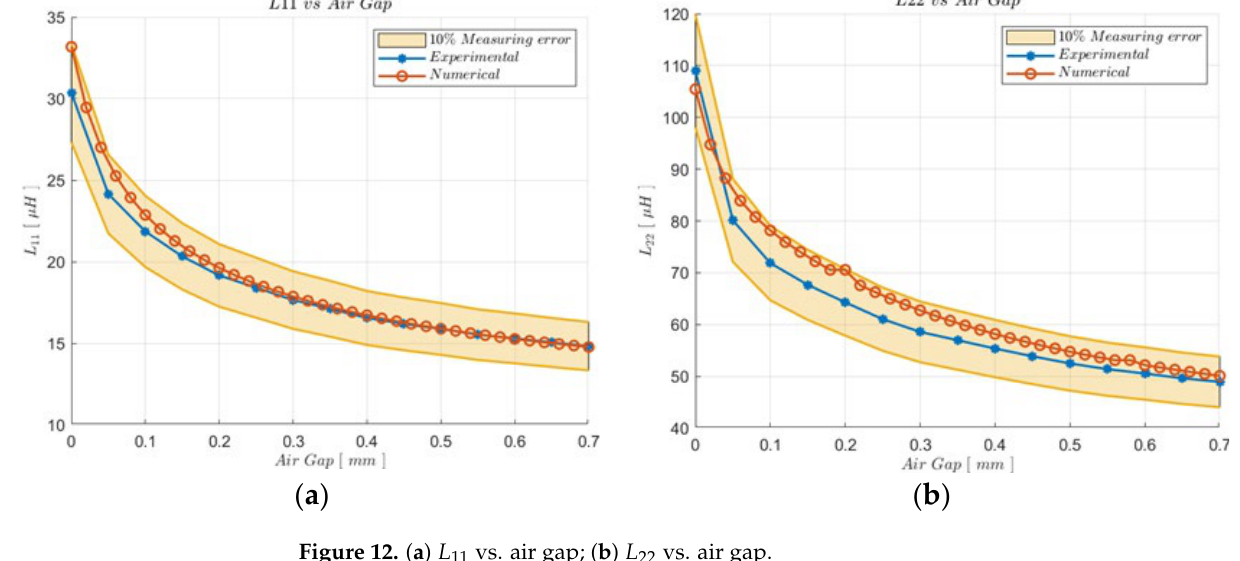
vs air gap. Figure 12. ( a ) L 11 vs. air gap; ( b ) L 22 vs. air gap. 𝐿𝐿 22